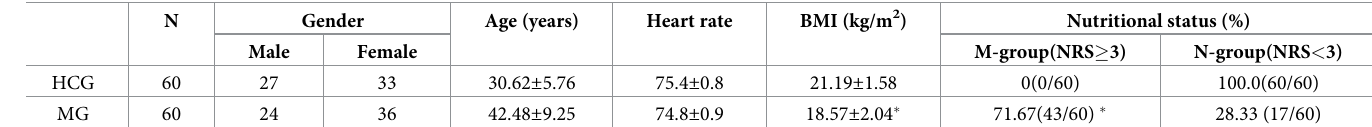
Table 1. Clinical information for all